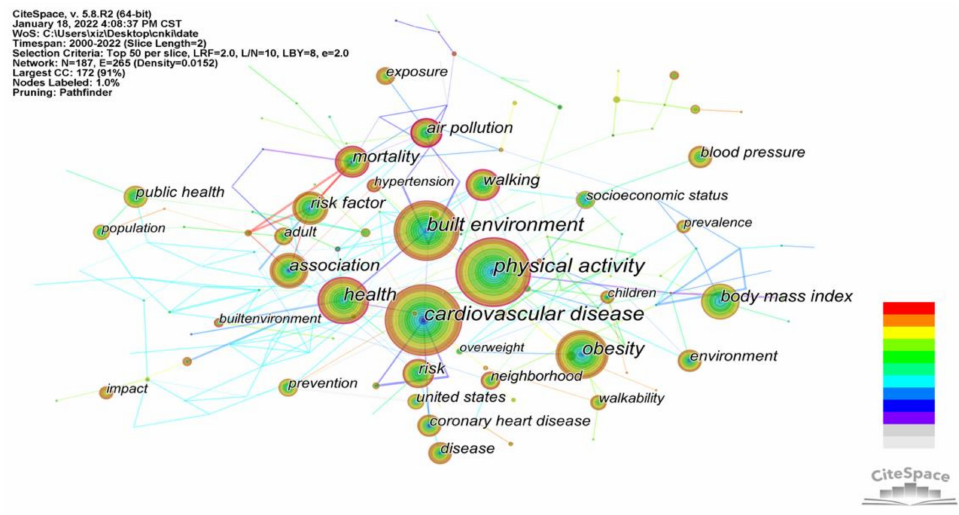
Figure 6. Knowledge map of analysis of co-occurring